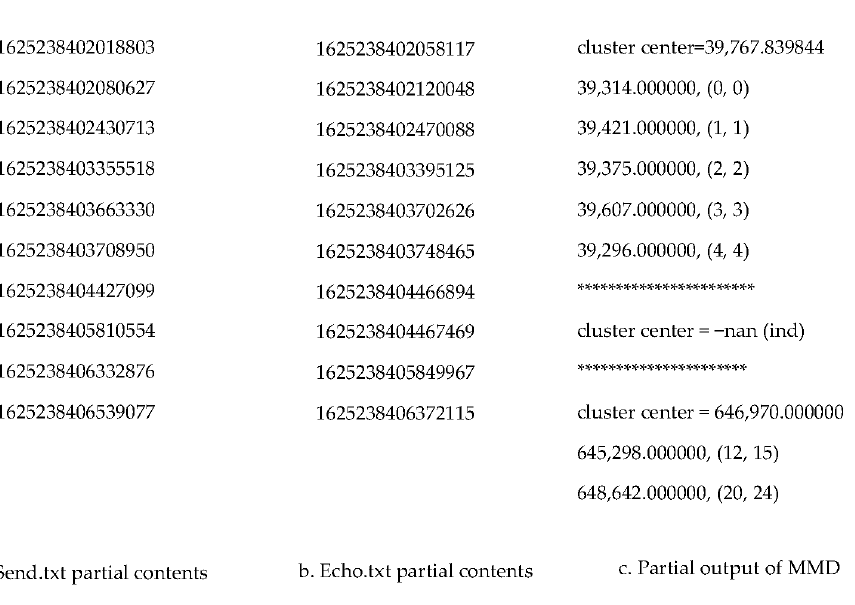
Figure 5. Input file format and output from MMD Data Mining Packet-matching.